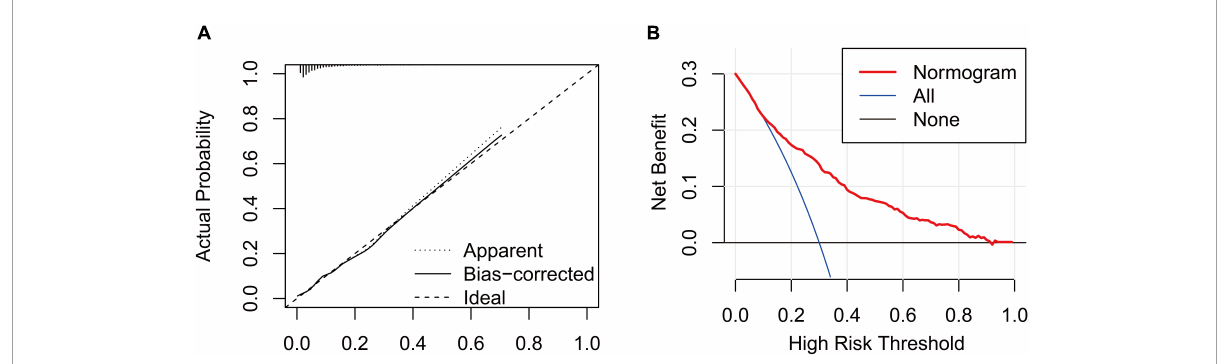
FIGURE6 (A) Calibration curve for the nomogram to predict the incidence of new-onset atrial fibrillation (NOAF) in patients with acute myocardial infarction (AMI). The x -axis represents the predicted incidence of NOAF and the y -axis denotes the actual incidence of NOAF. The solid line shows the bias-corrected performance. 1,000 bootstrap repetitions; mean absolute error = 0.005; n = 3,194. (B) Decision curve analysis for the incidence of NOAF in patients with AMI, implicating the net benefit with respect to the use of the